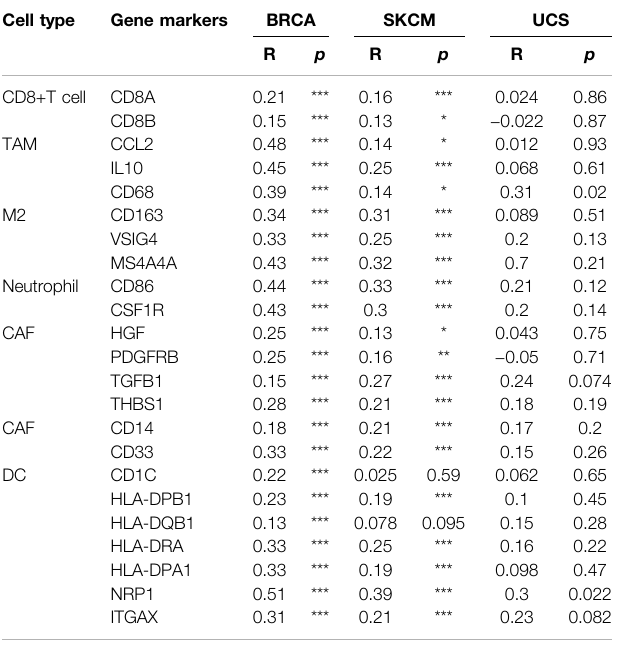
TABLE 2 | Correlations between ACSL4 and Gene Markers of CD8 + T cell, TAM, M2, Neutrophil, CAF in GEPIA. Cell type Gene markers BRCA SKCM UCS